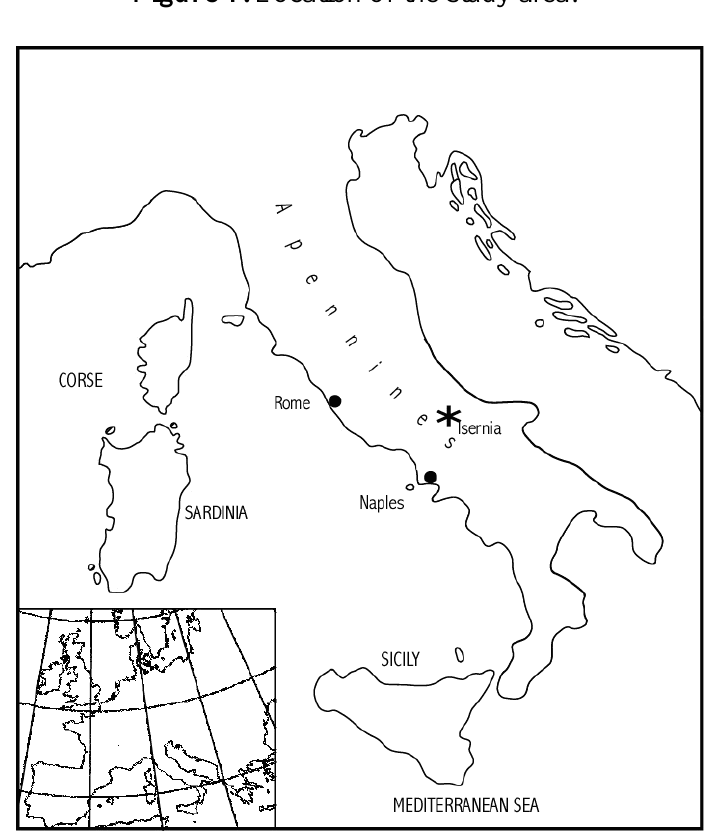
Figure 1. Location of the study